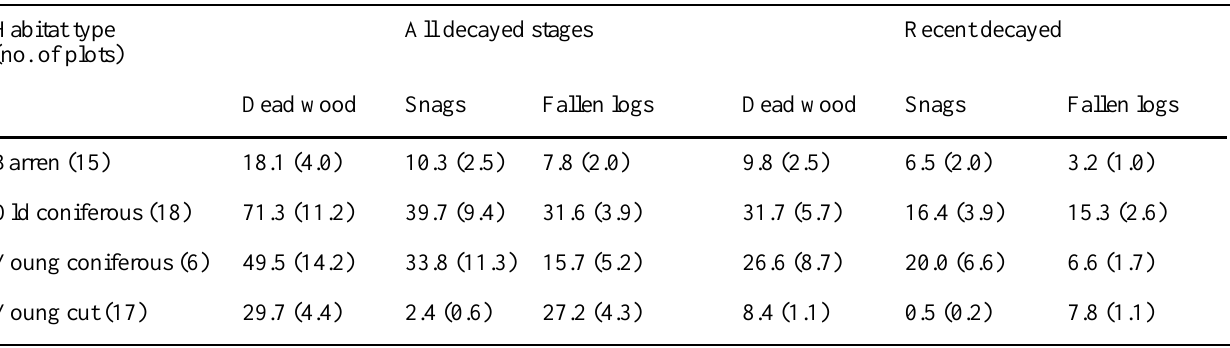
Table 3. Mean (SE) dead wood, snags, and fallen log volumes (m³ • ha -1 ) of total and recently decayed stages (decay classes 1 and 2) by habitat